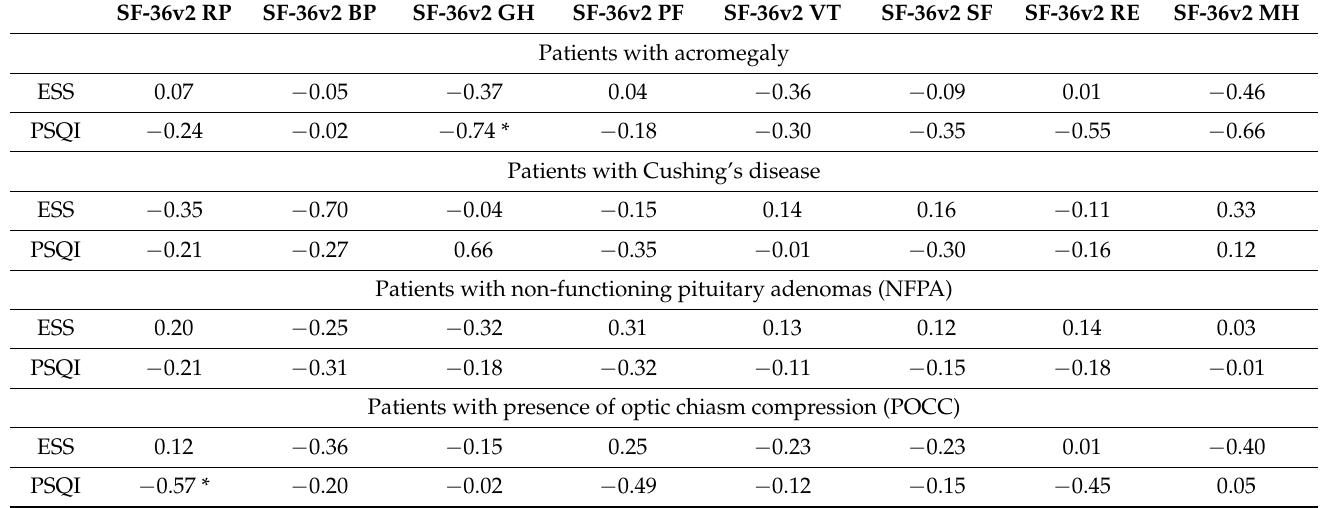
Table 3. Relationship between Epworth Sleepiness Scale (ESS) scores, Pittsburgh Sleep Quality Index (PSQI) scores, and Short-Form Health Survey version 2 (SF-36v2) scores in patients with acromegaly, patients with Cushing’s disease, patients with non-functioning pituitary adenomas (NFPA), patients with presence optic chiasm compression (POCC), and patients with absence of optic chiasm compression (AOCC) in